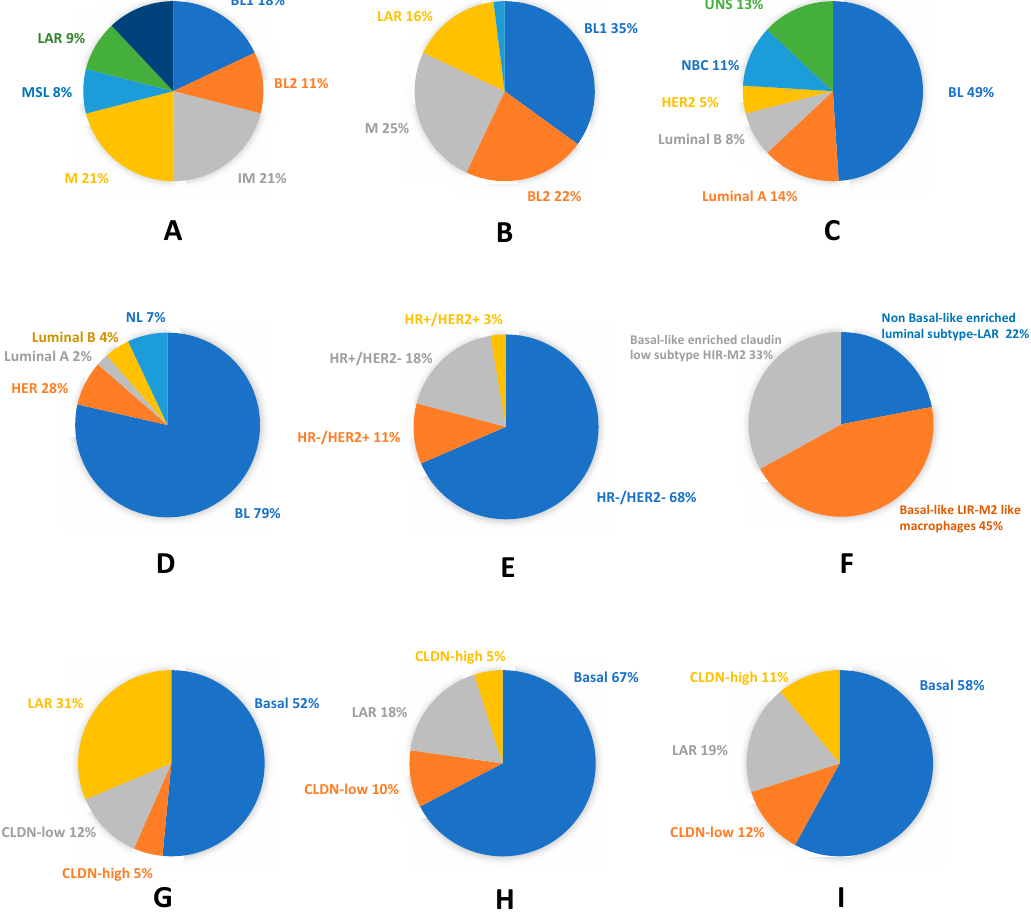
Figure 1. Molecular and phenotypic heterogeneity of Triple Negative breast cancer (TNBC): ( A ) pie chart showing frequencies and molecular TNBC type-6 classification (according to Lehmann et al. 2011) [13]; ( B ) pie chart displaying frequencies and molecular TNBC type-4 classification (according to Lehmann et al. 2011) [41]; ( C ) TNBC assigned to intrinsic molecular breast cancer (BC) subtypes (according to Lehmann et al. 2011) [13]; ( D ) pie chart showing molecular subclassification and frequencies of basal-like phenotype (BLP) in TNBC (according to Prat et al. 2013) [44]; ( E ) pie chart displaying molecular subclassification and frequencies of TNP in BLBC (according to Prat et al. 2013) [44]; ( F ) pie chart showing the fuzzy clustering of TNBC (according to Jezequel et al.) [45]; ( G ) pie